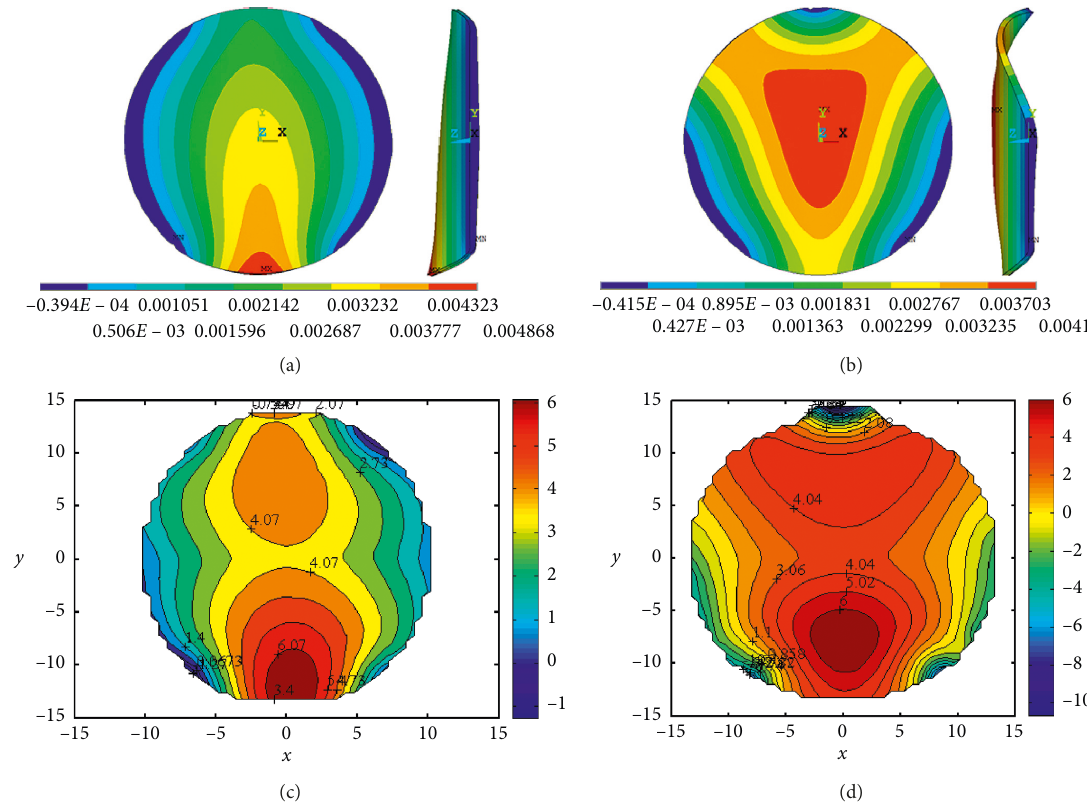
Figure 5: Deformation contour maps of front view and left view under pressures of (a) 130Pa and (b) 104Pa. Mean power distribution under different pressures of (c) 130Pa and (d) 104